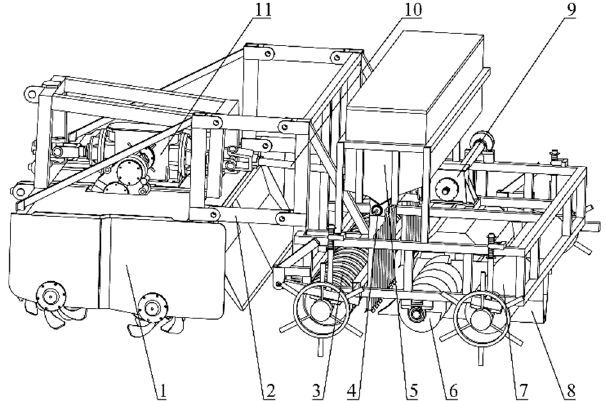
Figure 1. General structure of compound planter. 1. Biaxial rotary tillage mechanism. 2. Connecting rod. 3. press grooving roller. 4. Seeder. 5. Seed box. 6. Spiral soil separating mechanism. 7. Repress roller. 8. Ditcher. 9. Steering box. 10. Transmission shaft. 11. Intermediate transmission box.